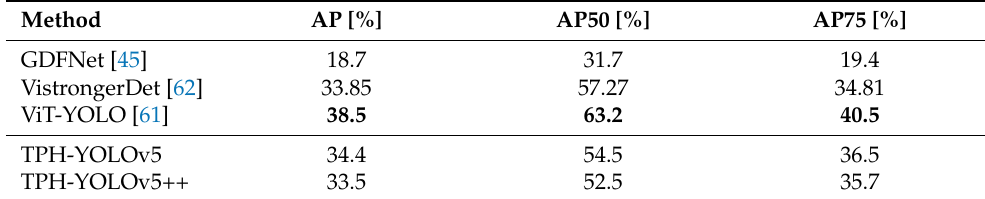
Table 3. Results of our methods and current SOTA methods on the VisDrone2021 test-dev set.